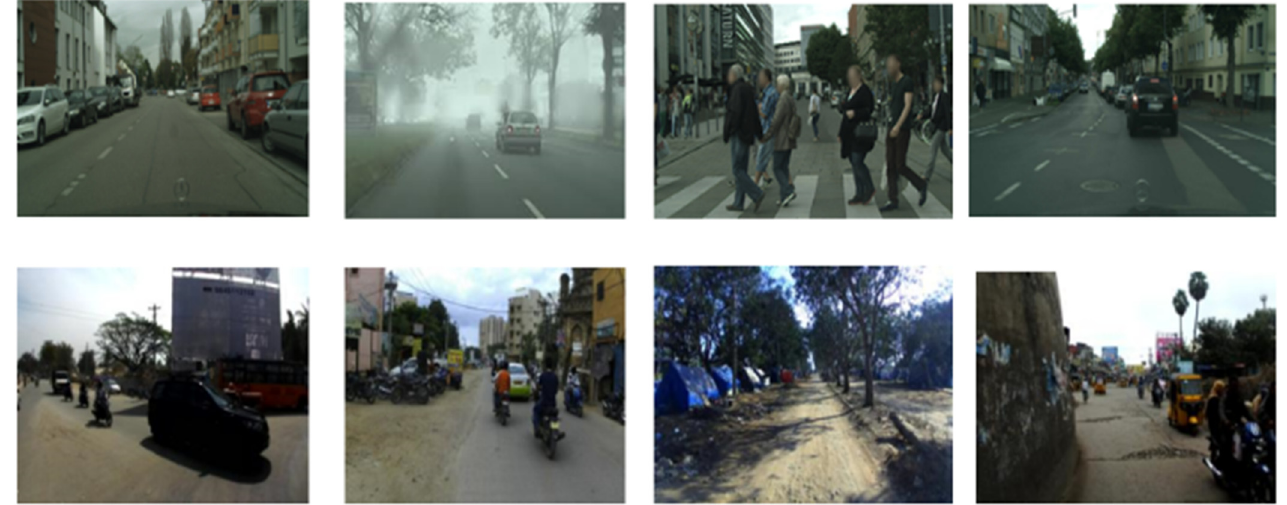
Figure 2. Some road scene images from structured (Cityscape) and unstructured (IDD) environments are in the first and second rows, respectively. Table 1. IDD-Lite dataset class labels with class names and the proportion of pixels in each